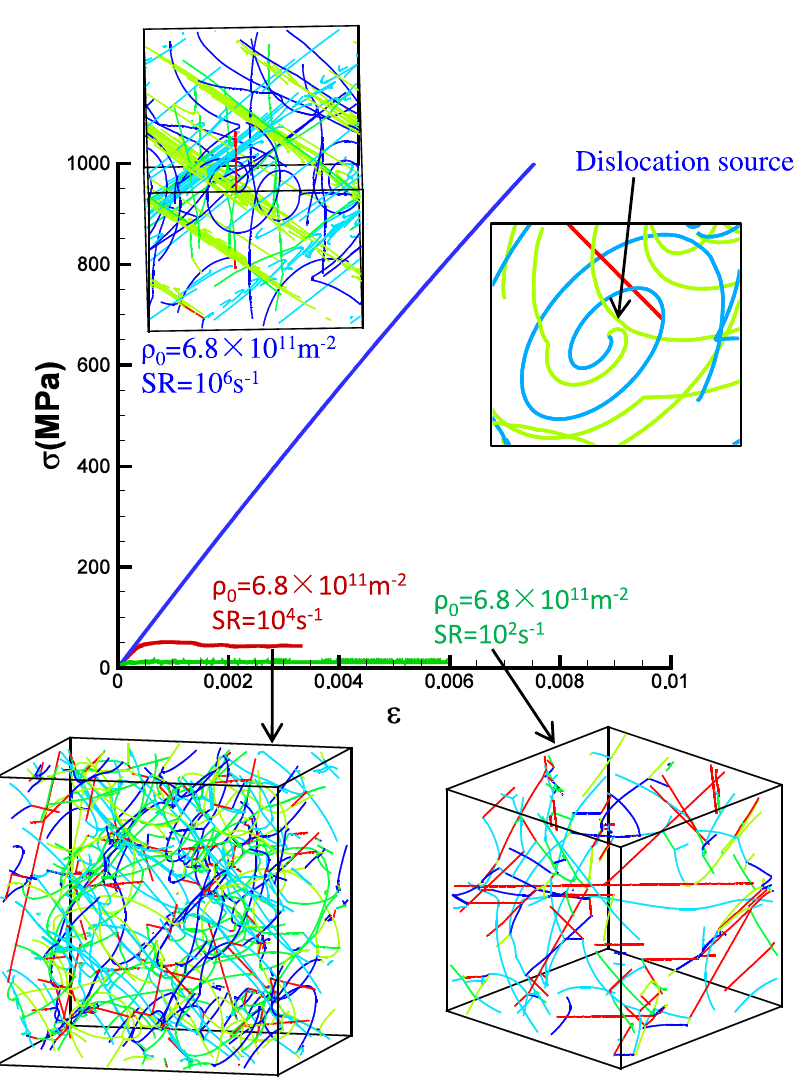
Fig. 5 Dislocation con fi gurations for same initial dislocation density but different strain rates. The shown simulation boxes have an edge length of 7.91 μ m. The dislocation evolution processes in the three cases are shown in Supplementary Movies 1-3. SR is abbreviation of strain rate.